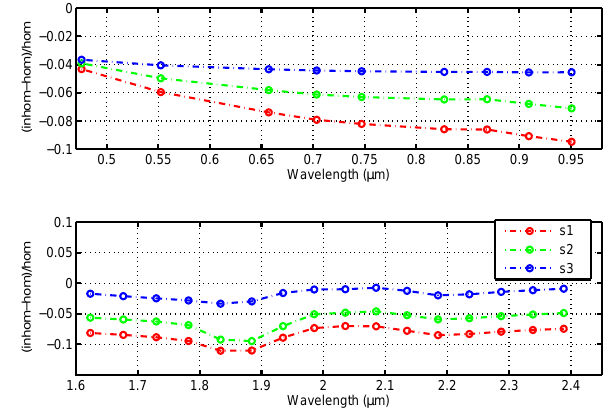
Fig. 16. Average extinction profile for Sector 1 (red), 2 (green) and 3 (blue) derived from CPL.